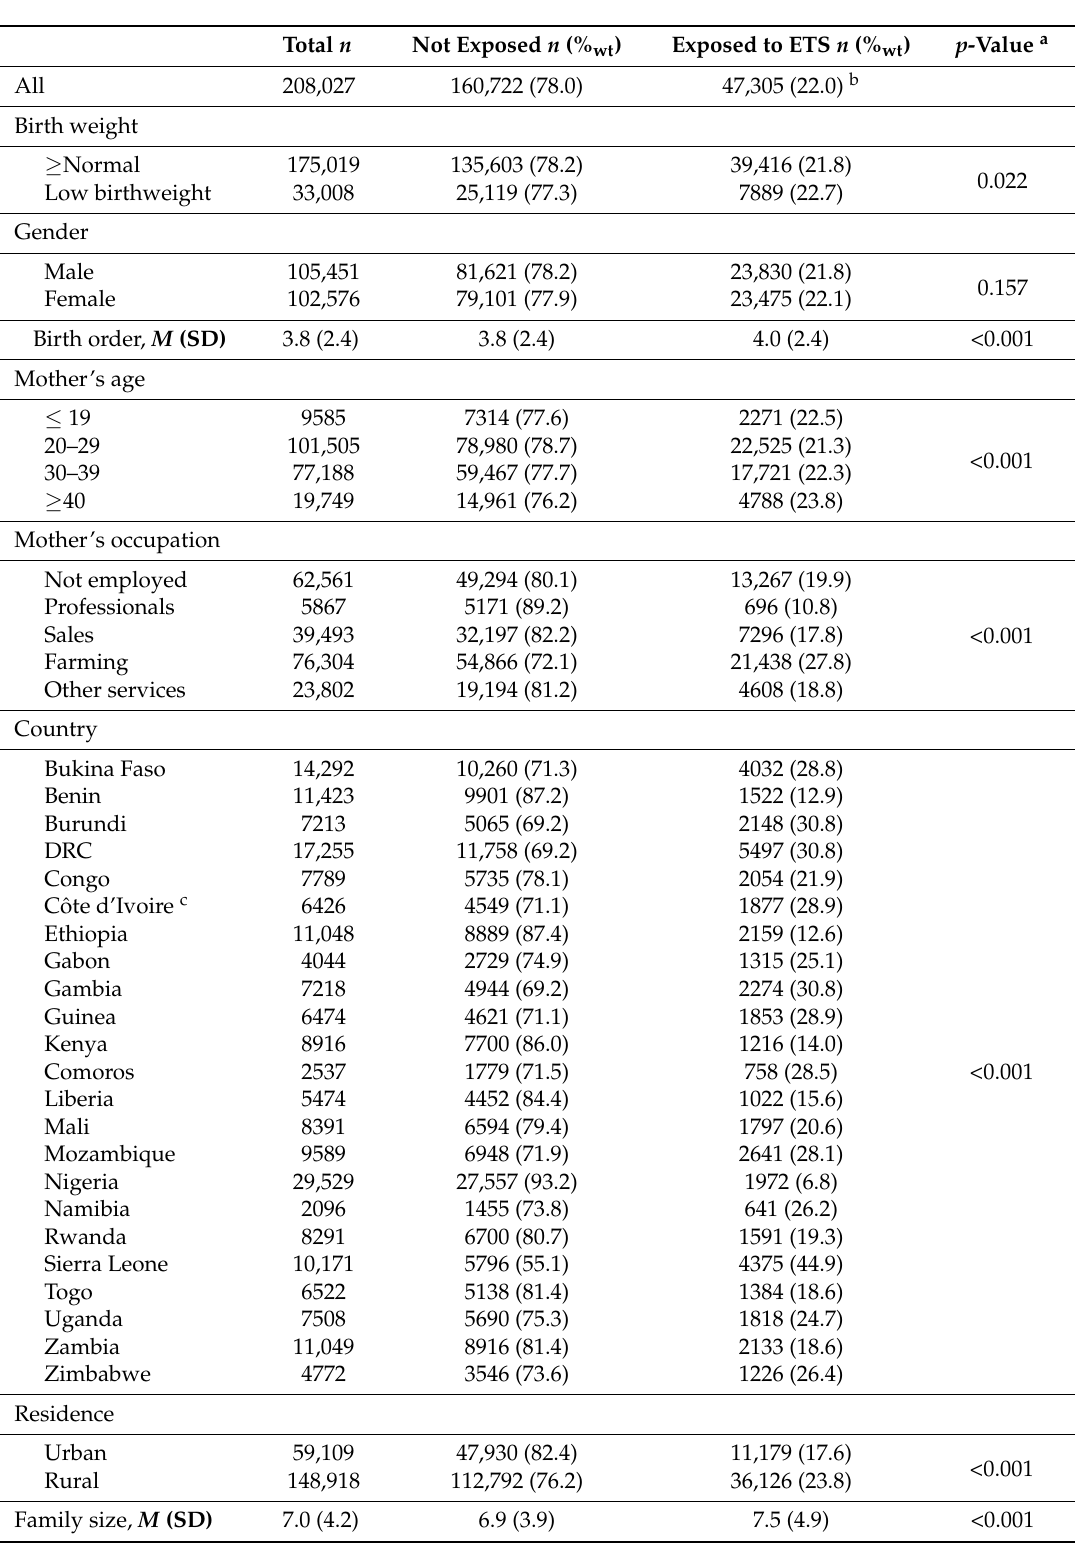
Table 1. Characteristics of participants by exposure to environmental tobacco smoke in Africa (Demographic Health Survey (DHS), 2010–2014). Total n Not Exposed n (% wt ) Exposed to ETS n (% wt